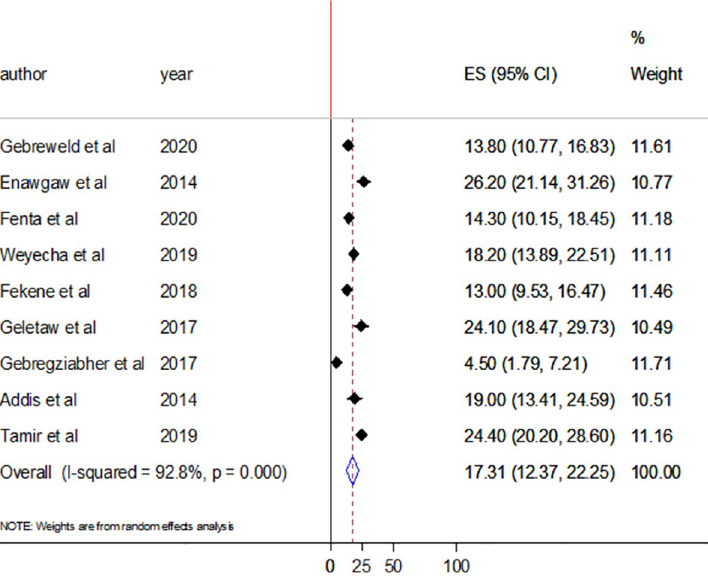
Fig 8. Forest plot showing the pooled prevalence of leucopenia among HIV/AIDS patients.